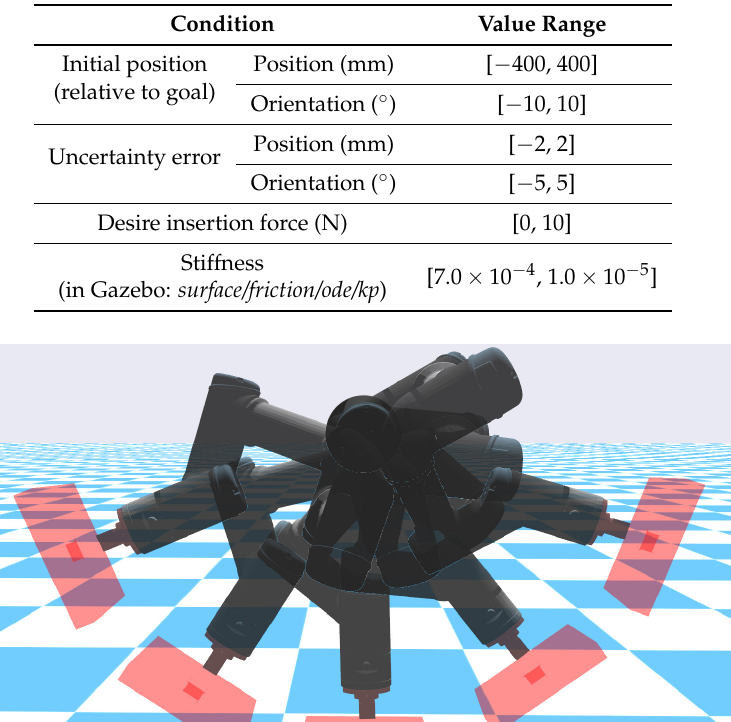
Table 1. Randomized training conditions.